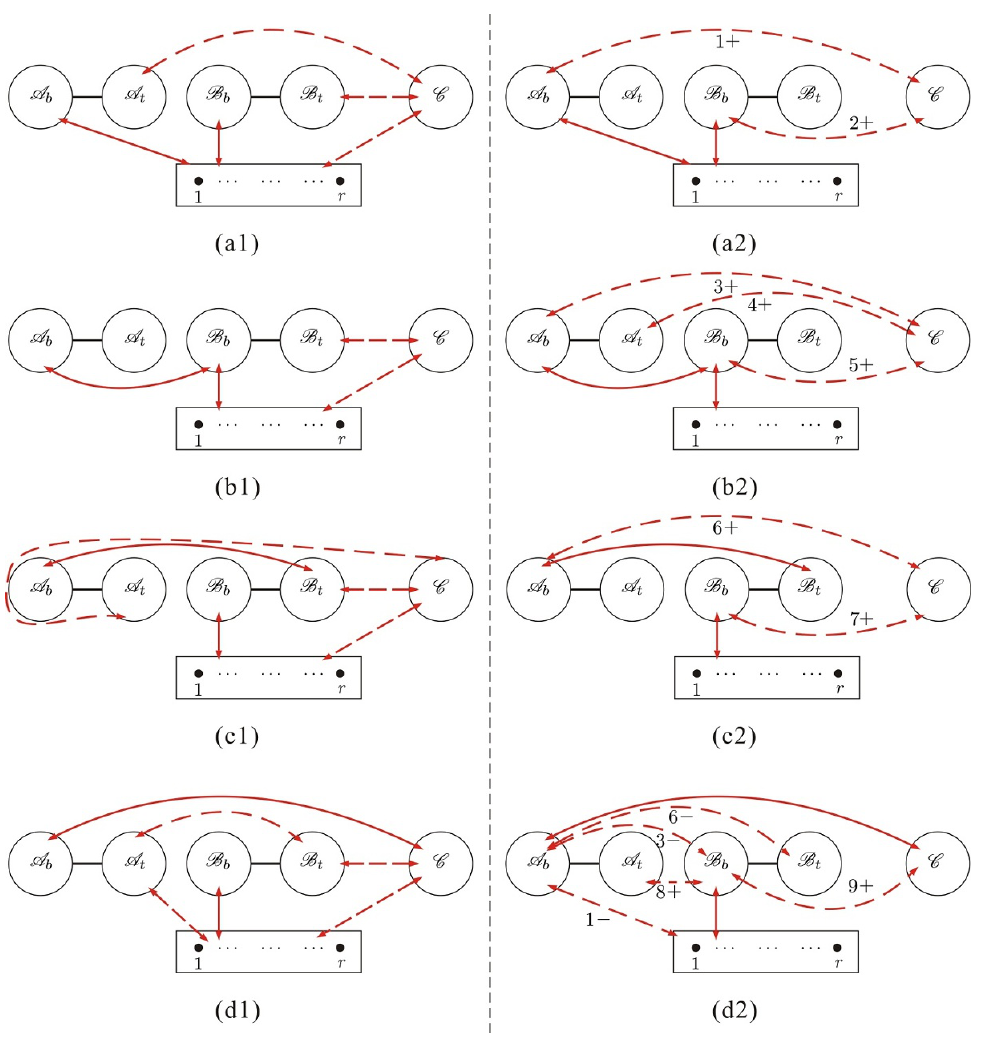
Figure 29 . Physical graphs (a1), (b1), (c1), (d1) for the skeleton (cid:12)gure 11 by construction-2 and the corresponding spurious graphs (a2), (b2), (c2), (d2): part